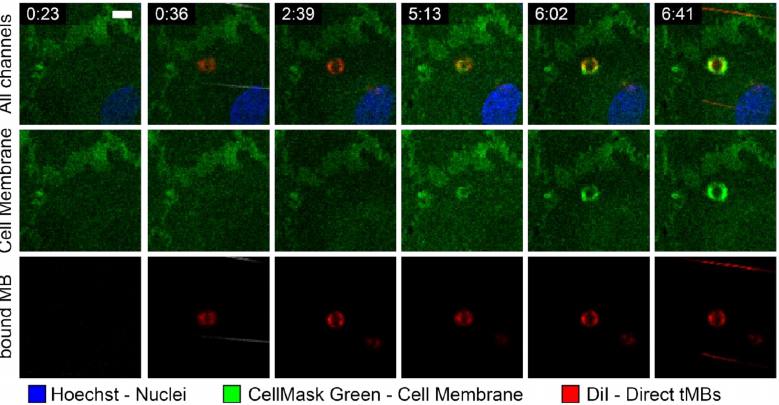
Figure 8. Internalization event of targeted direct microbubble (diameter 5.9 µ m) over time indicated with min:sec, at a shear stress of 1.25 dyn/cm 2 and with targeted microbubbles added at 0:15. Scale bar represents 10 µ m and applies to all